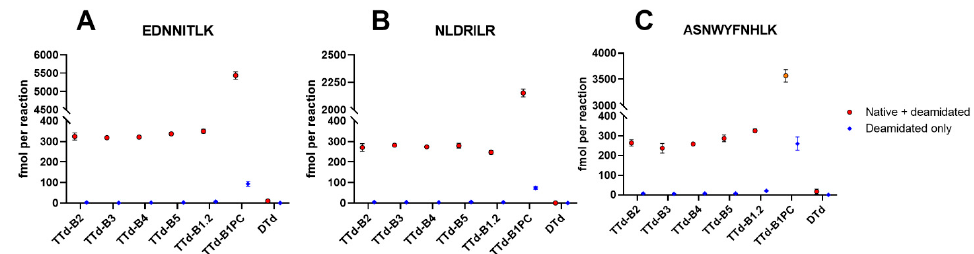
Figure 4. Temperature sensitive formation of peptides ( A ) EDNNITLK, ( B ) NLDRILR, and ( C ) ASNWYFNHLK by partial digestion with cathepsin S of tetanus toxoid batches of the same manufacturer. TTd-B1.2 was used as a reference and is two years older than TTd-B2–TTd-B5, an aliquot of TTd-B1.2 exposed to 55 °C for two days is used as a positive control (TTd-B1PC). Diphtheria toxoid of the same manufacturer was used as a negative control. Error bars represent the SD of three enzymatic digestions of aliquots of the same batch.